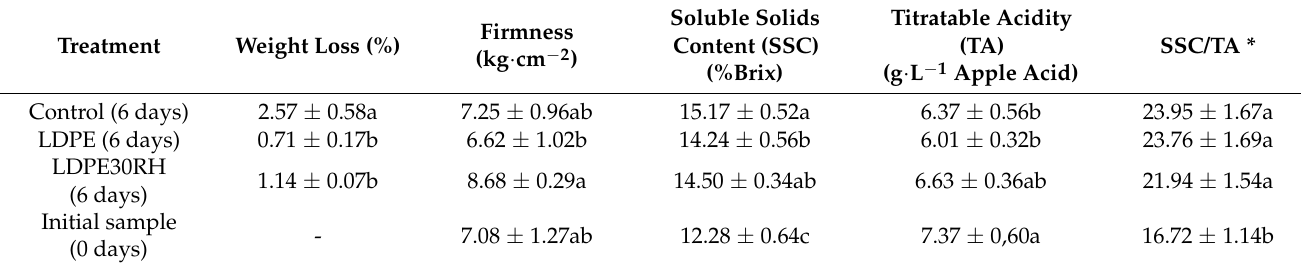
Figure 14. Respiration dynamics of apples, ‘Granny Smith’, for 6 days at room temperature under the influence of LDPE and LDPE 30% RH films. Table 8. Quality of Apples. ‘Granny Smith’, postharvest and 6 days at room temperature under the influence of LDPE and LDPE films 30% RH (mean ± standard